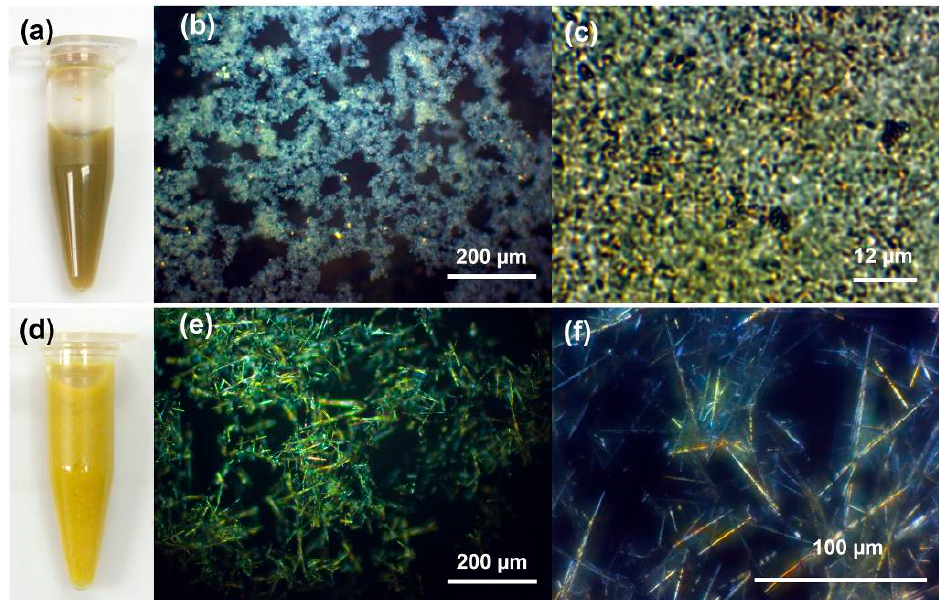
Figure 2. ( a ) Photograph of Au-Cu salt precursors in solution; ( b , c ) Polarized optical microscope (POM) images of Au-Cu salt precursors; ( d ) Photograph of Au-Cu-Pd salt precursors in solution; ( e , f ) POM images of Au-Cu-Pd salt precursors.